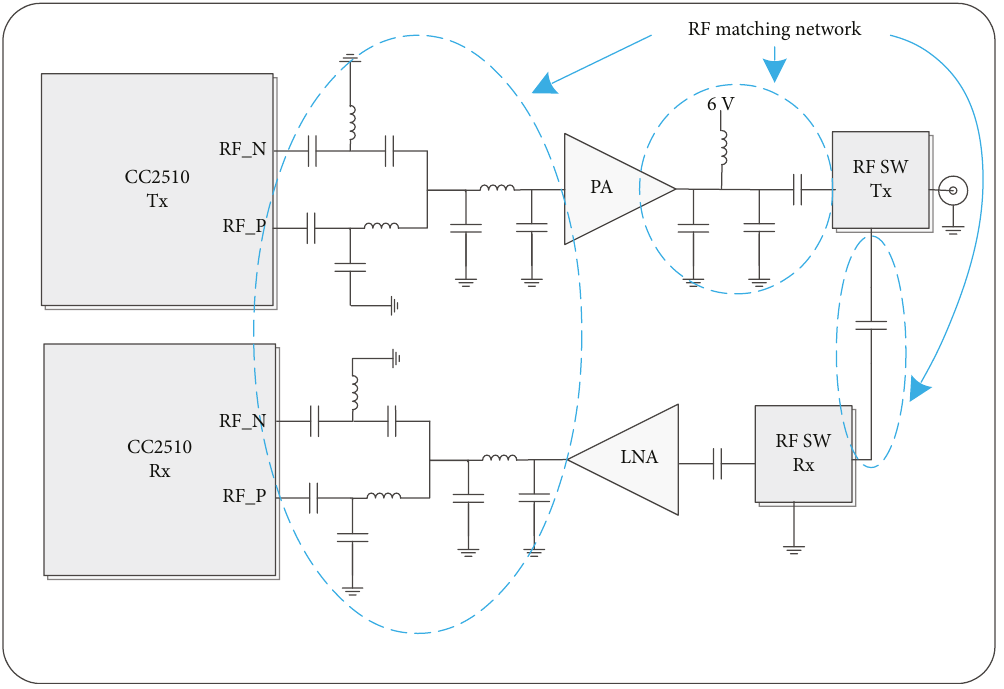
Figure 10: RF front-end block